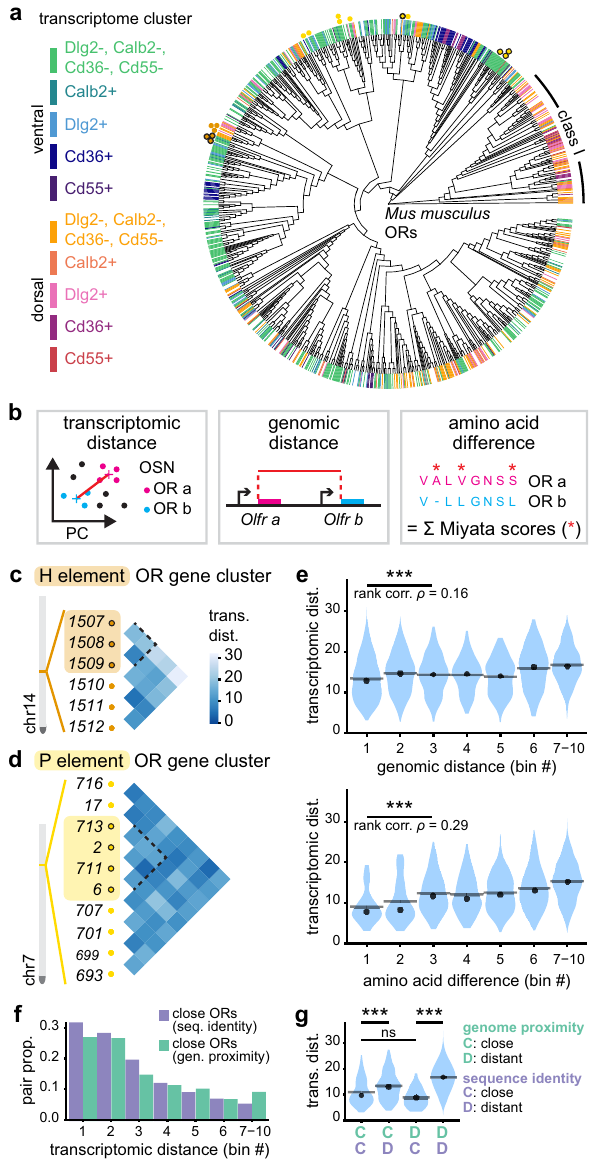
Fig. 2 Association between transcriptomic distances and odorant receptor similarity levels. a 1152 mouse odorant receptor (OR) phylogeny. Colored bars show the transcriptomic identity of the olfactory sensory neuron (OSN) population expressing a given OR. Colored dots indicate that the corresponding OR belongs to the gene cluster analyzed in ( c , d ). b Schematics of the different metrics used to express distance between pairs of OSN populations. From left to right, transcriptomic distance (Euclidean distance between centroids of OSN population transcriptomes in the PCA space), genomic distance (base pairs between OR gene start codons), amino acid difference (sum of Miyata amino acid replacement scores between OR protein sequences). c Pairwise transcriptomic distances between OSN populations expressing OR genes in the same cluster on chromosome 14. The orange box highlights H element-regulated OR genes. The dotted line in the pairwise distance matrix encompasses comparisons between OR genes under control of the H element. d Same analysis as in ( c ) but for OR genes under the control of the P element, on chromosome 7. e Distribution of transcriptomic distances per bins of either genomic distances (top) or amino acid differences (bottom), for all pairs of ORs belonging to the same class and the same gene cluster ( n = 3602 pairs). Transcriptomic distances and genomic distances: Spearman ’ s rank correlation ρ = 0.16, *** p < 0.001, n = 2598 pairs. Transcriptomic distances and amino acid differences: Spearman ’ s rank correlation ρ = 0.29, *** p < 0.001, n = 222 pairs. Correlation scores ( ρ ) and associated p values between the transcriptomic distances and each of the different metrics was calculated for the pairs included in the three fi rst bins. f Proportions of closely related pairs of OSN populations across bins of transcriptomic distances. Close pairs are de fi ned depending on either their genomic distance or their amino acid differences. g Transcriptomic distance distribution of four categories of OSN population pairs de fi ned by a combination of their genomic distances and amino acid differences. adjusted with a Bonferroni correction. Exact p values are provided in Supplementary Table 1. Source data are provided as a Source Data fi